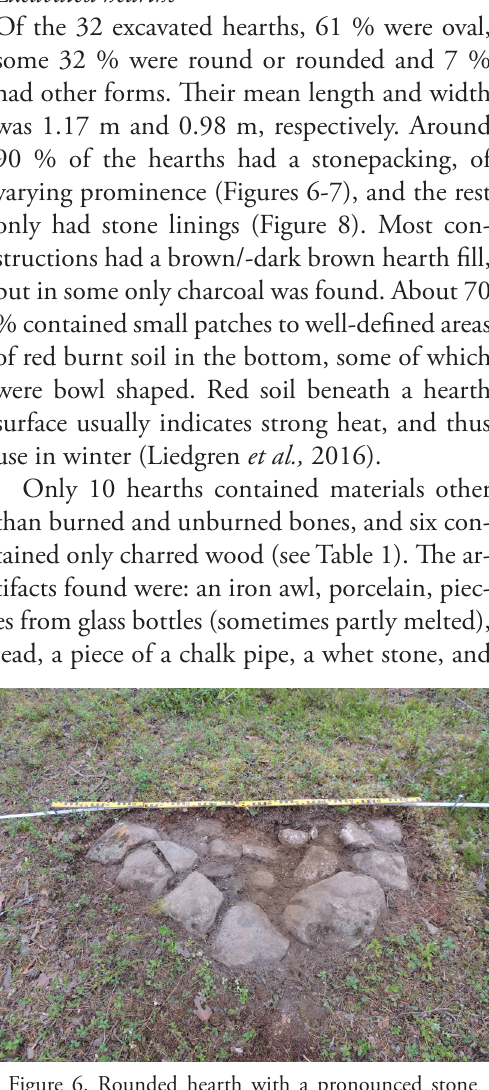
Figure 6. Rounded hearth with a pronounced stone packing from area 3, NHB 358:5. Bones from the hearth are 14 C-dated to the period AD 1480-1660. Artifacts found in the hearth show that it can not be older than the 17 th century.